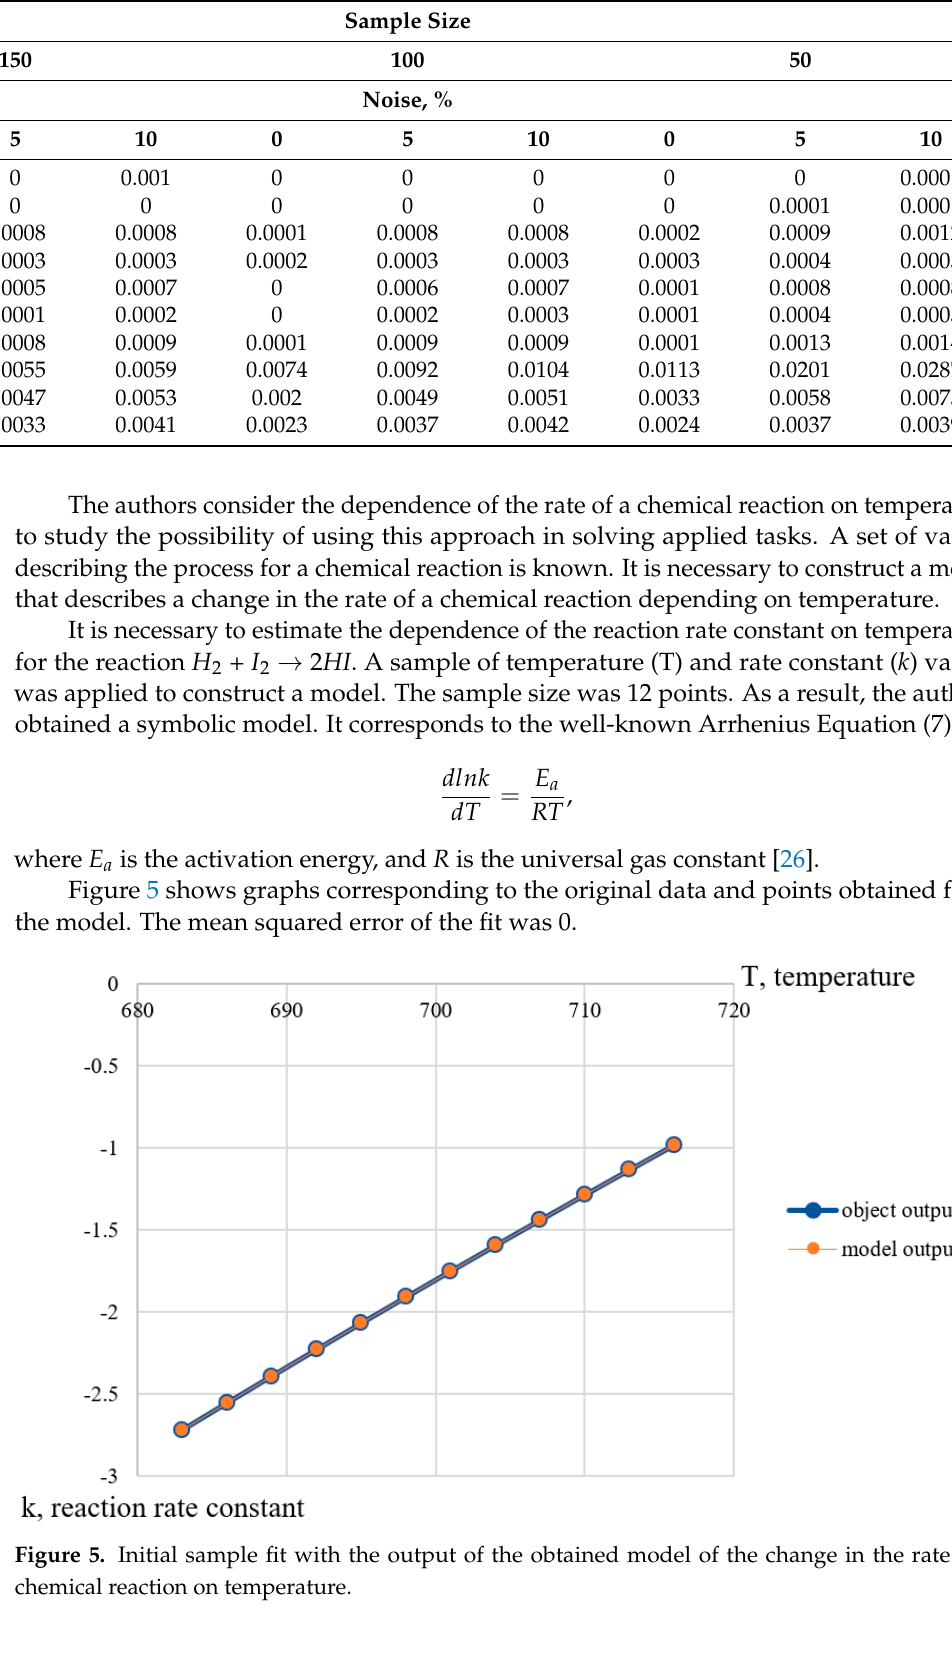
Table 3. Test tasks for the evolutionary approach to the identification of dynamical systems in the form of an ODE system. No